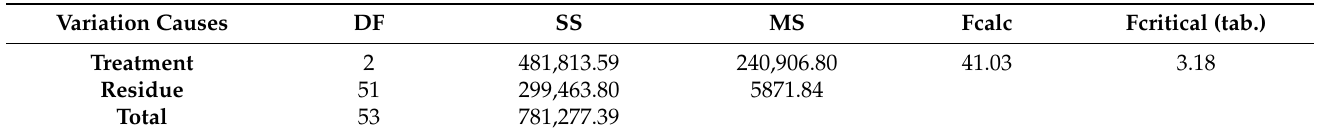
Table 2. ANOVA for the Izod absorbed impact energy of epoxy composites with different volume fractions of guaru- man fibers.